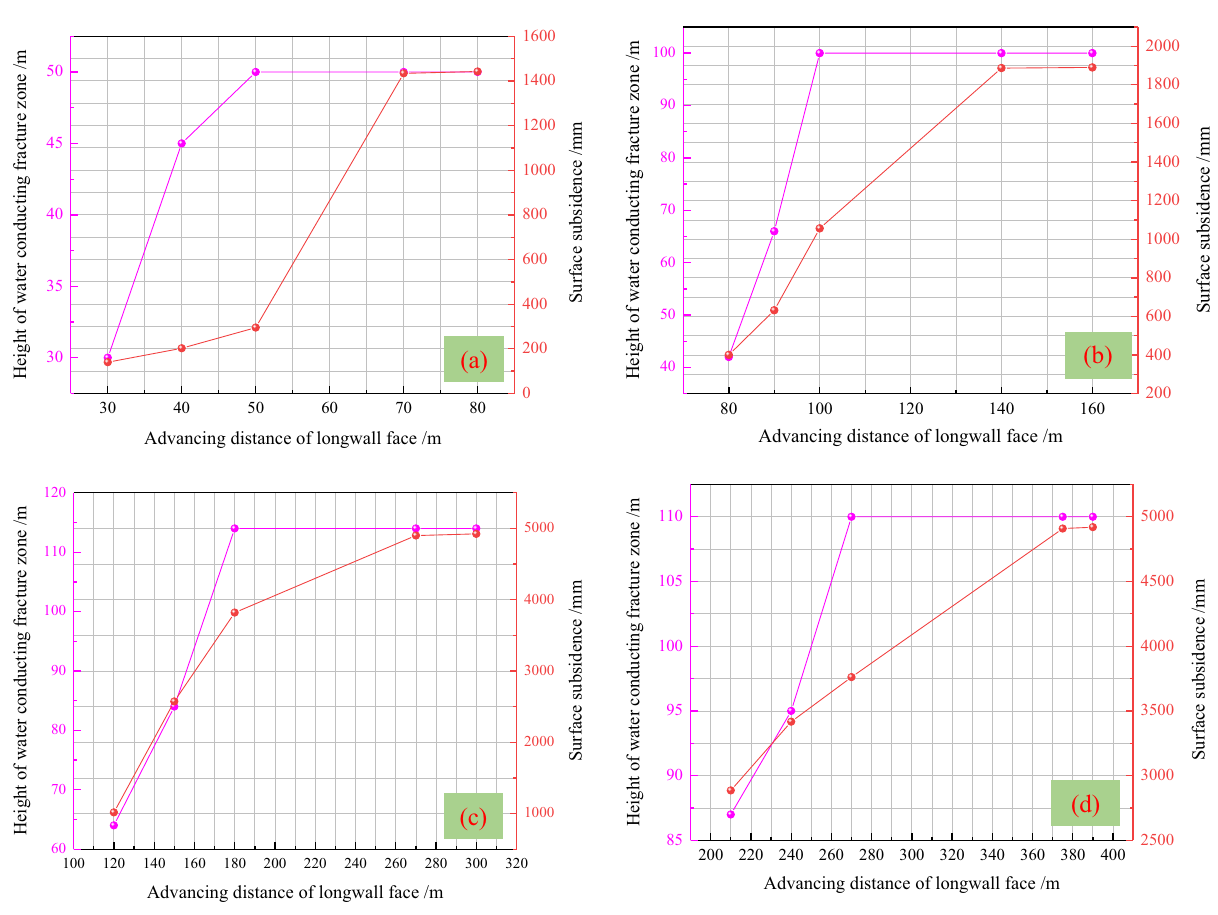
Figure 11. Variation law of water-conducting fractured zone and surface subsidence. ( a ) Buried depth 50 m. ( b ) Buried depth 100 m. ( c ) Buried depth 220 m. ( d ) Buried depth 300 m.